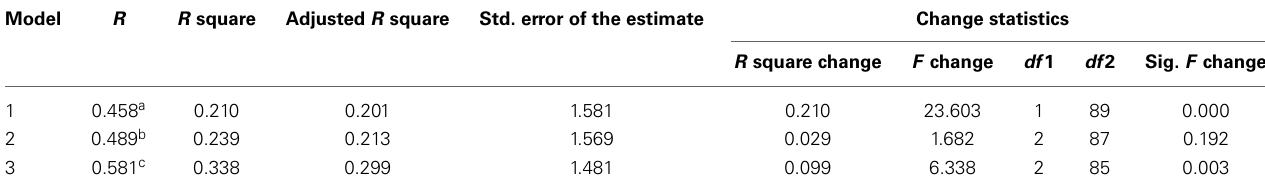
Table 5 | Model and R 2 Change summary predicting IC-B.